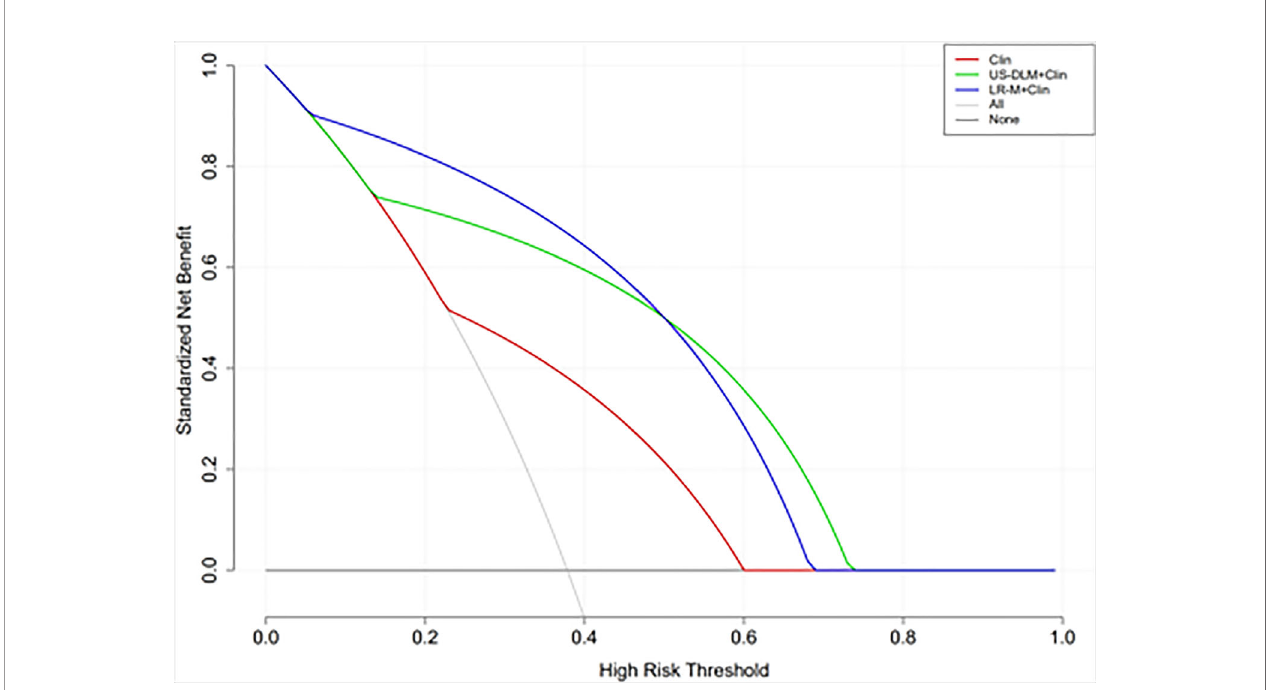
FIGURE 6 | Decision curve analysis of different nomogram models for predicting probability of OM in the test cohort. The y-axis represents net bene fi t. The dark and grey lines measure the bene fi t of using the “ all OMs ” and “ all HCCs ” strategies, respectively. Clin, clinical features; DLM, deep learning model; LR-M, liver imaging and reporting system